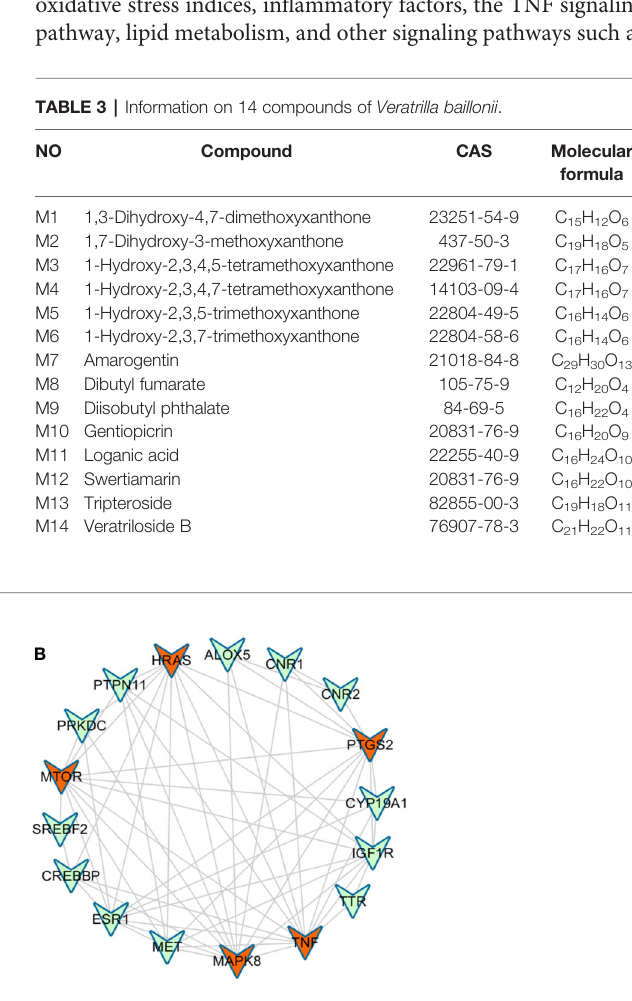
FIGURE 2 | Target network analysis. (A) Venn diagram of active ingredient targets and disease proteins. (B) Fourteen active ingredients of Veratrilla baillonii and cross-critical disease targets. Blue represents the protein at the intersection of the active compound with the disease. Red is the active